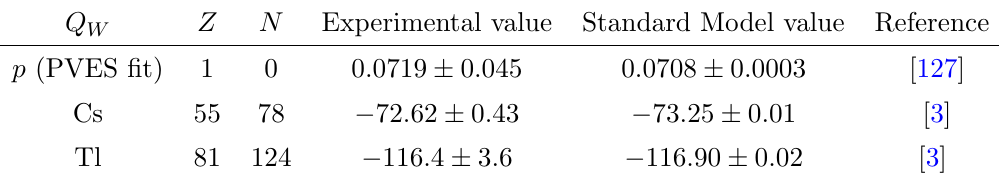
Table 8. Summary of experimental measurements of weak charges of the proton, cesium, and